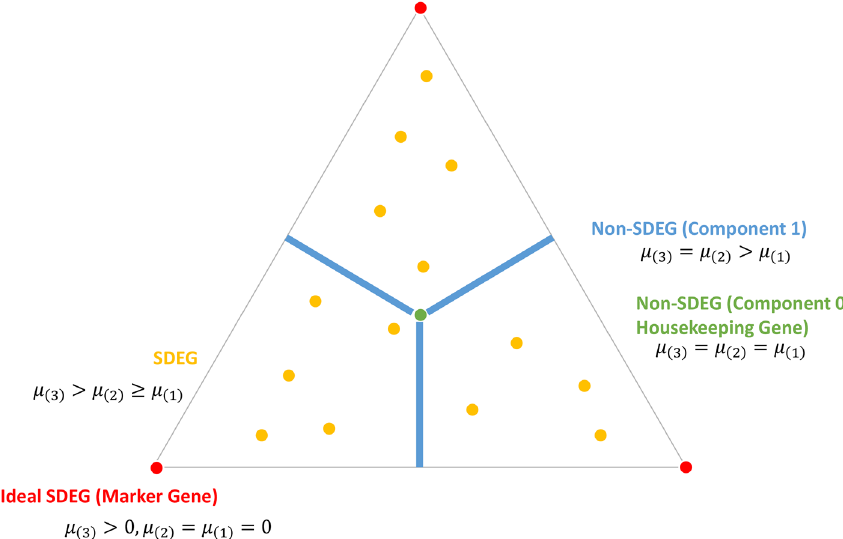
Figure 1. Illustrative simplex of three subtypes. Given the definition of SDEGs, and for simplicity, consider a scenario where three subtypes have the mean values µ ( 1 ) ≤ µ ( 2 ) ≤ µ ( 3 ) and define d j = µ ( 3 ) − µ ( 2 ) . The SDEGs and non-SDEGs can be illustrated in a simplex plot, where yellow/red points are SDEGs under the alternative hypothesis d j > 0 and blue/green points are non-SDEGs under null hypothesis d j = 0 . OVE-sFC is to test whether d j is significantly larger than zero and thus matches the definition of